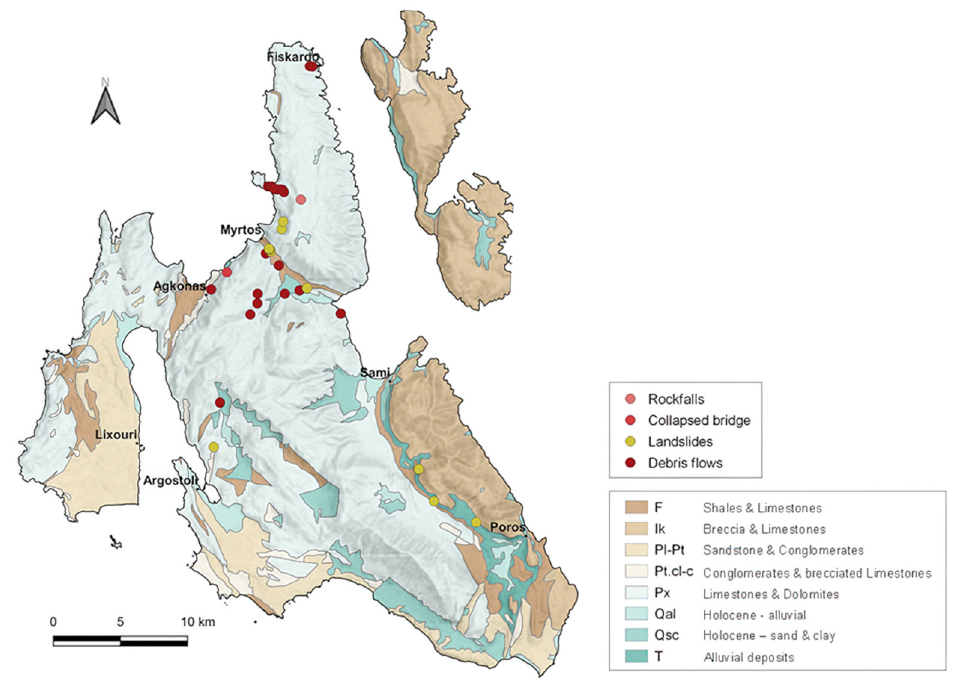
Figure 10. Lithological map of Cephalonia Island with observed landslides and related phenomena following Medicane Ianos. Modified from [35,37].